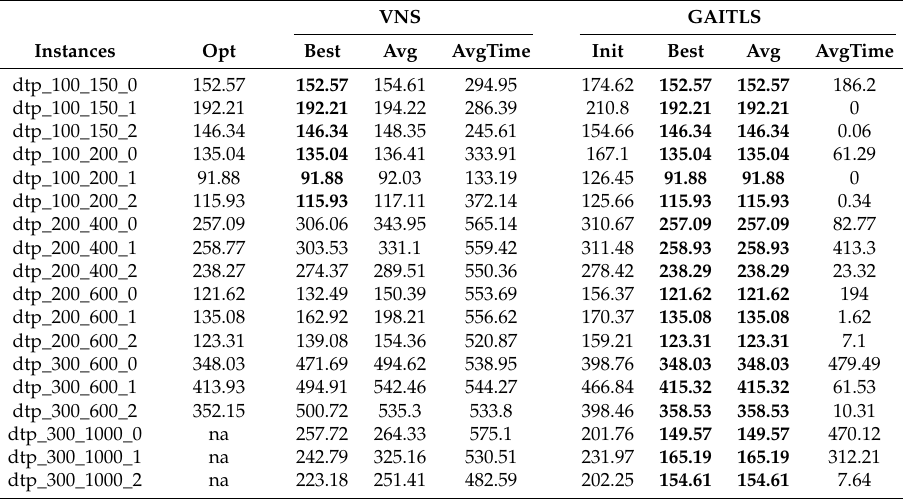
Table 2. Experimental results of VNS and GAITLS on large instances of dtp.